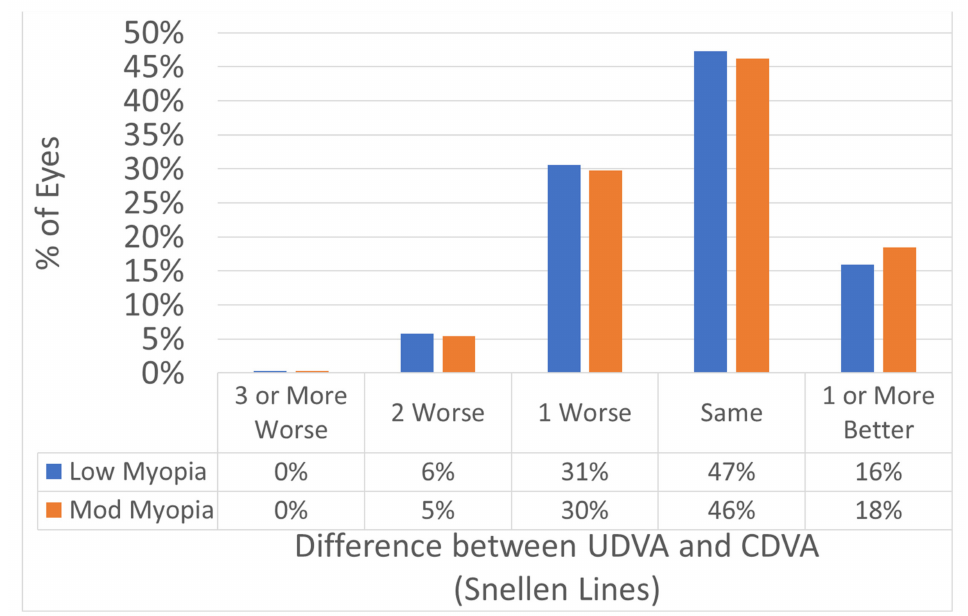
Figure 2. Efficacy expressed in Snellen lines. The postop UDVA was − 0.3 ± SD 0.8 lines worse than the preop CDVA in both groups ( p = 0.5). In 94% of the eyes the postoperative UDVA was within 1 line of the preoperative